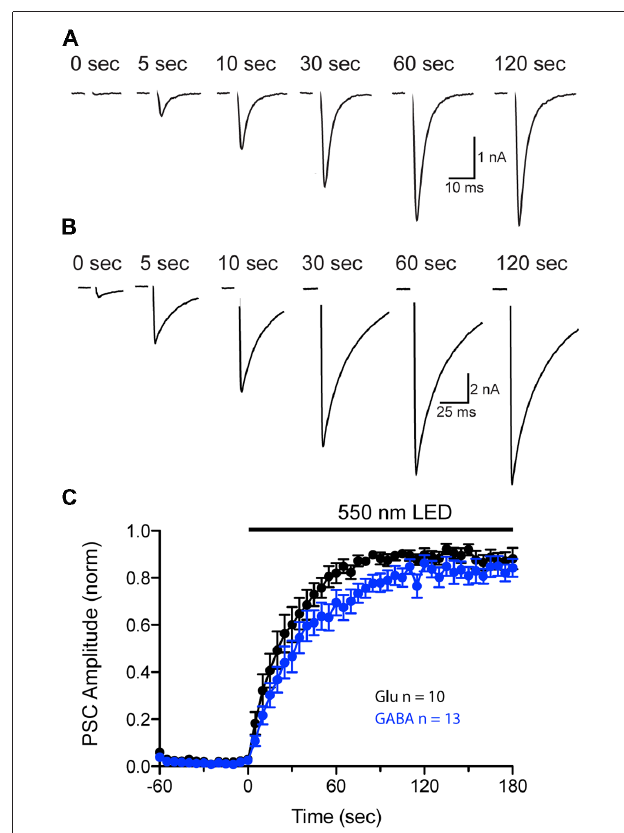
FIGURE 8 | Comparison of pHoenix-driven Postsynaptic current (PSC) recovery in glutamatergic and GABAergic autapses. (A,B) PSCs recorded from a representative bafilomycin-treated glutamatergic (A) or GABAergic (B) autaptic cultured neuron expressing pHoenix at indicated time points during a 120 s exposure to 550 nm light. Depolarization-evoked, unclamped action potential has been blanked for illustrative purposes. (C) Average recovery time course of PSCs from bafilomycin-treated, pHoenix-expressing glutamatergic (black; n = 10 cells; two independent cultures) and GABAergic (blue; n = 13 cells; two independent cultures) autaptic neurons. For each cell, baseline PSC amplitudes (60 s pre-light exposure) were subtracted then normalized to the peak response during a 180 s exposure to 550 nm